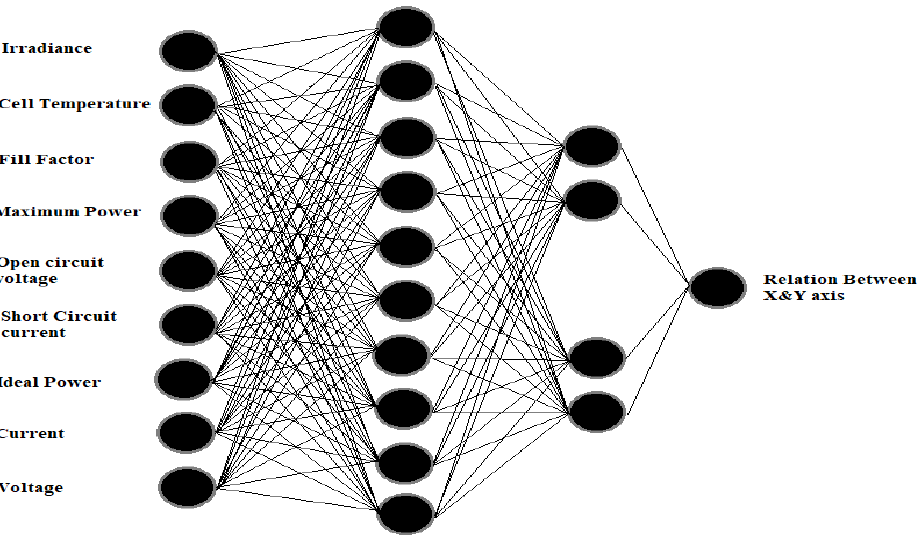
Figure 4. The first proposed GRNN flowchart to predict the relation between the X and Y